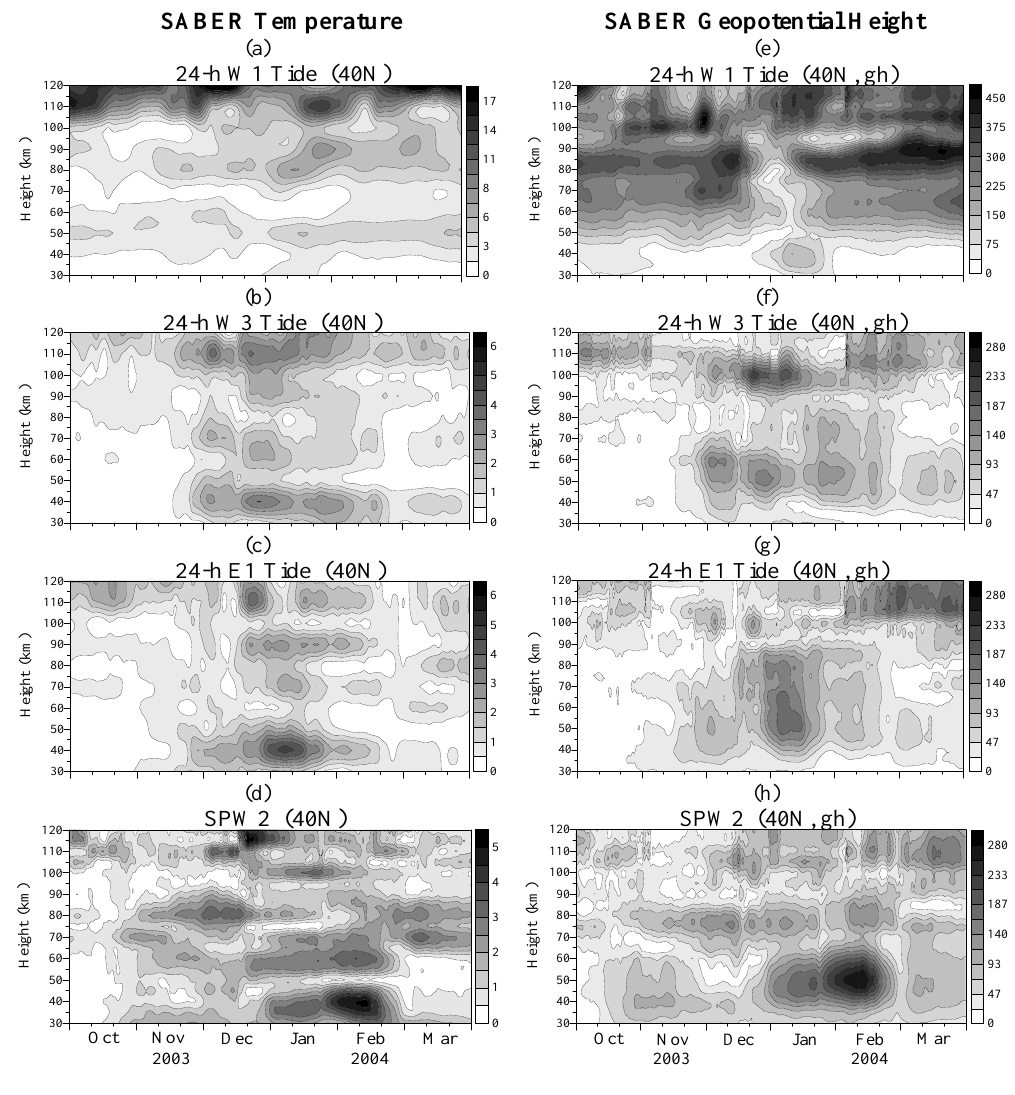
Figure 5 Fig. 5. Altitude-time cross sections of the following amplitudes: migrating W1 tide ( a and e ), nonmigrating W3 tide ( b and f ), nonmigrating E1 tide ( c and g ), and SPW2 ( d and h ) seen in the SABER temperatures (left column of plots) and geopotential heights (right column of plot) at 40 ◦